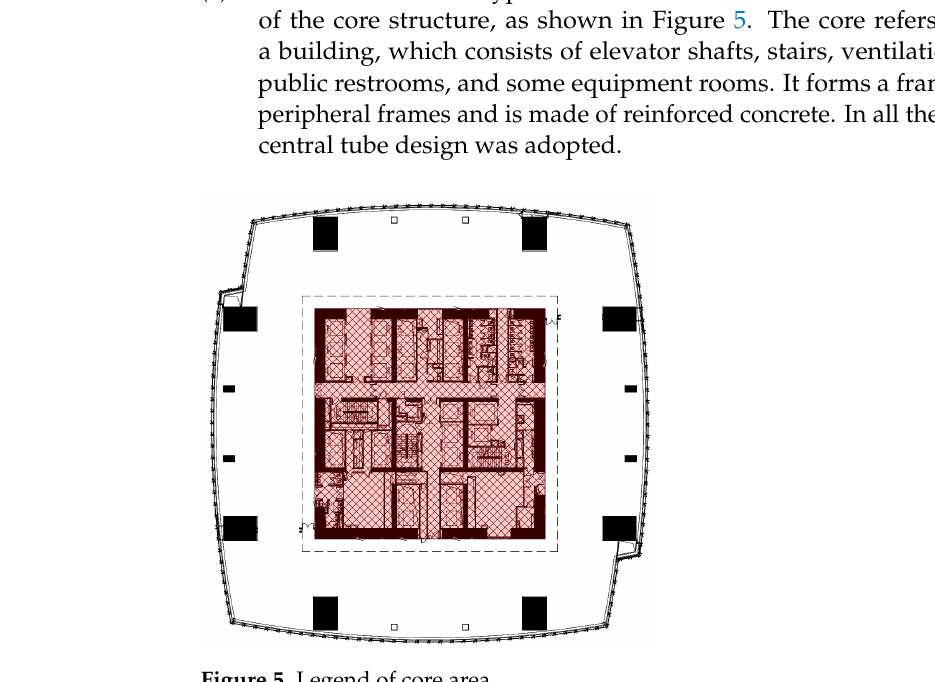
Figure 4. Legend of Traffic Space Area.